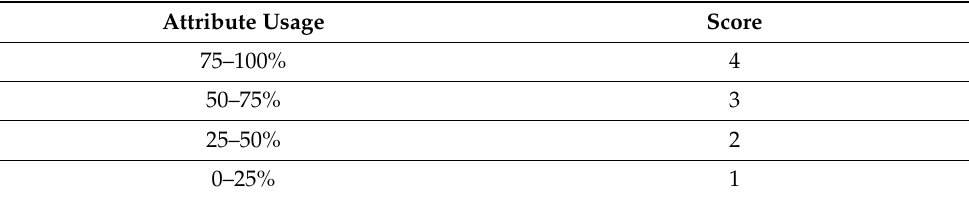
Table 2. Scores for different intervals of attribute